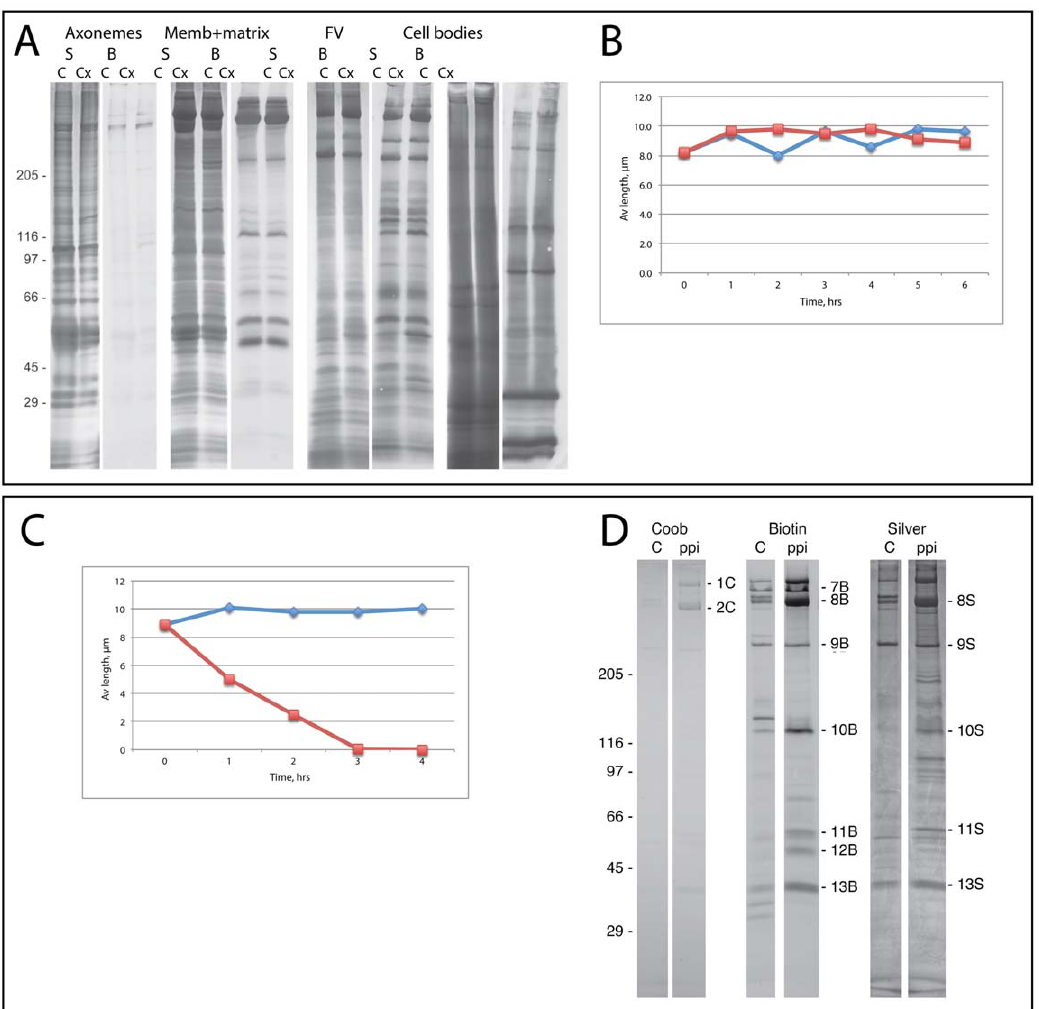
Figure 3. Flagellar vesicles continued to be shed and surface proteins replaced as cells were incubated with cycloheximide, to inhibit protein synthesis while maintaining full-length flagella (A, B). Sodium pyrophosphate induced flagellar shortening and increased the release of flagellar vesicles (C, D). A: Biotinylated cells were incubated without (C) or with (Cx) 10 m g/ml cycloheximide for 6 hrs and then were pelleted, deflagellated, and flagella were extracted with NP-40 to produce axonemes and membrane + matrix. Shed flagellar vesicles (FV) were purified from the medium and cell bodies were sedimented after deflagellation. Identical volumes of axonemes, membrane + matrix, and FV were stained for total protein (S) or biotinylated protein (B). B: Aliquots of cells were fixed during the 6 hr incubation and flagellar lengths were measured on control cells (diamonds) or cycloheximide-treated cells (squares). Cycloheximide did not induce flagellar length changes. C: Cells with full-length flagella (diamonds) maintained full length while 20 mM sodium pyrophosphate induced flagella to shorten (squares). D: Equal volumes of biotinylated cells were incubated without (C) or with (ppi) pyrophosphate for 4 hrs as flagella on pyrophosphate-treated cells resorbed. Shed flagellar vesicles were purified, suspended in equal volumes of buffer, fractionated by SDS-PAGE, and stained for total protein (Coob, Silver) or for biotinylated proteins (Biotin). Densitometric analysis of individual bands, identical in MW to those analyzed in regenerating flagella (Fig. 4) is presented in Table 2.